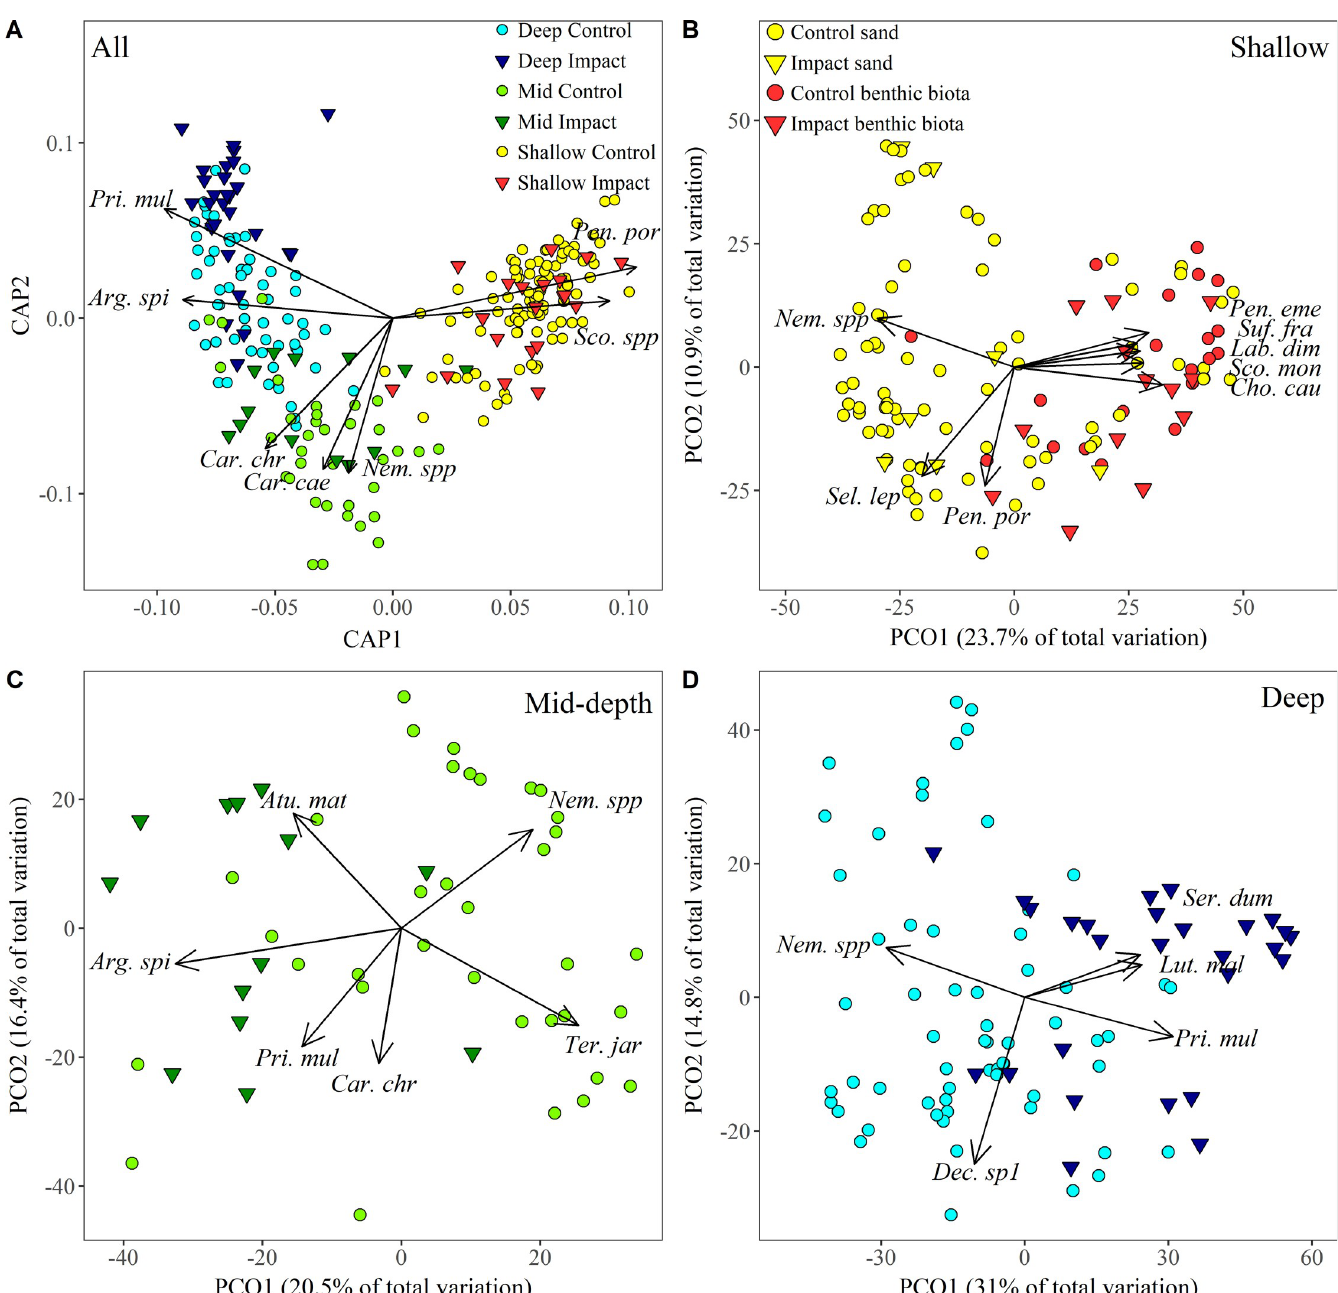
Fig 3. CAP and PCO plots using the relative abundance of fish. A) A CAP plot illustrating the grouping of deployments using the combined factor Location x Depth displays separation of depths; B-D) PCO plots illustrating patterns in the relative abundance of fish assemblages in depths < 40 m (B), in 40–80 m (C) and in > 80 m (D). Species with a Spearmen correlations of |R| � 0.5 (A), |R| � 0.6 (B, D) and |R| � 0.65 (C) to either axis are overlaid with vectors indicating the strength of the correlation (longer vectors indicate higher |R|) and the direction in which each species is shaping the distribution of